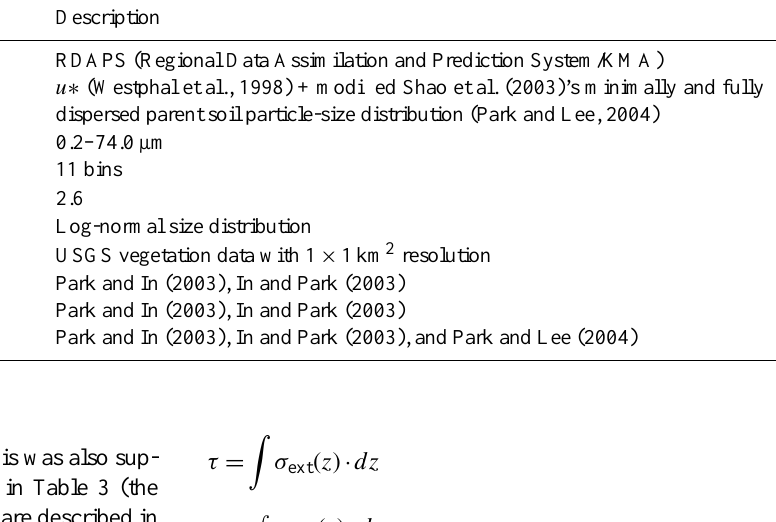
Table 2. Description of ADAM (Kim et al.,